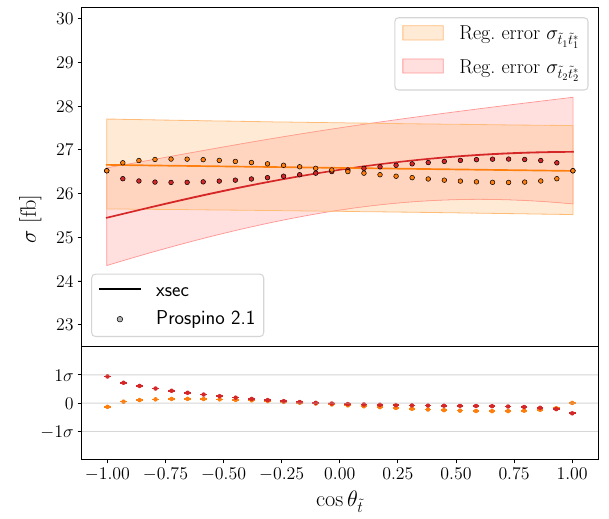
Fig. 20 Stop pair-production cross-sections as a function of the stop mixing angle cos θ ˜ t . The central-value xsec prediction and the regres- sion error band is shown in orange ( ˜ t 1 ˜ t ∗ on the prediction are the Prospino values (dots)